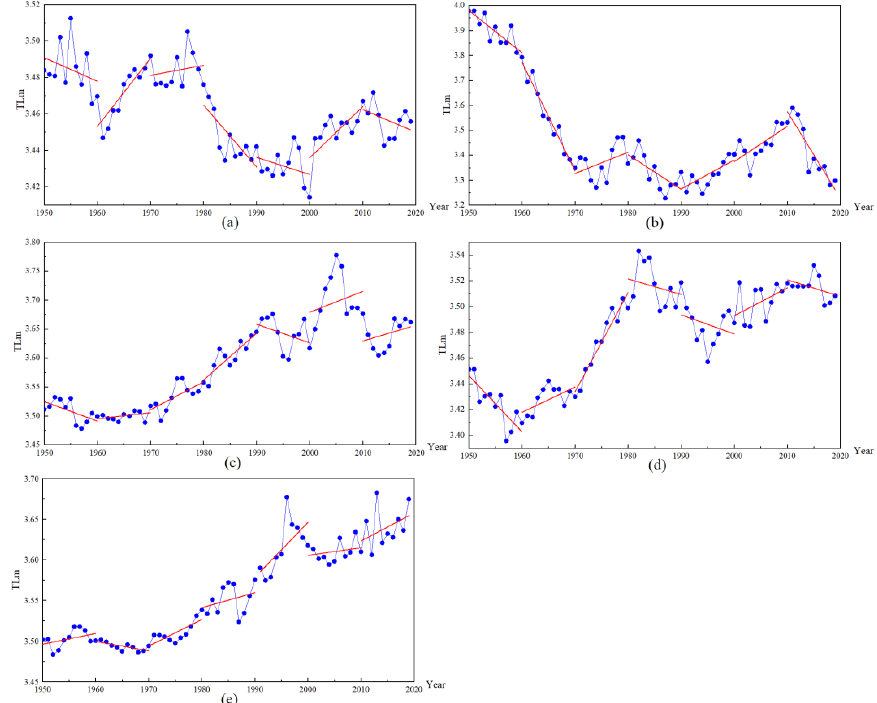
Figure 3. Trends of mean trophic level of fishery landings in Africa during 1950 – 2019: ( a ) North Africa; ( b ) East Africa; ( c ) Central Africa; ( d ) West Africa; ( e ) Southern Africa. Note: Red lines visualize the Slope, by decade. The results were calculated according to Formulas (1), (3), and (4). Both TLm indexes in Central Africa (Slope = 0.003, R 2 = 0.73) and West Africa (Slope = 0.002, R 2 = 0.63) showed a similar steady upward trend during 1950 – 2019. The TLm index in East Africa showed a downward trend (Slope = 1.84, R 2 = 0.4), while the 3.25 TLm